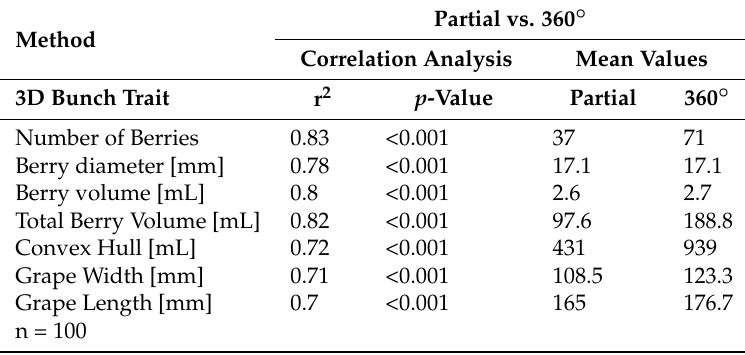
Table 3. Correlation Coefficient r 2 and significance ( p -values) and mean values of seven 3D bunch traits between partial and 360 ◦ scan.